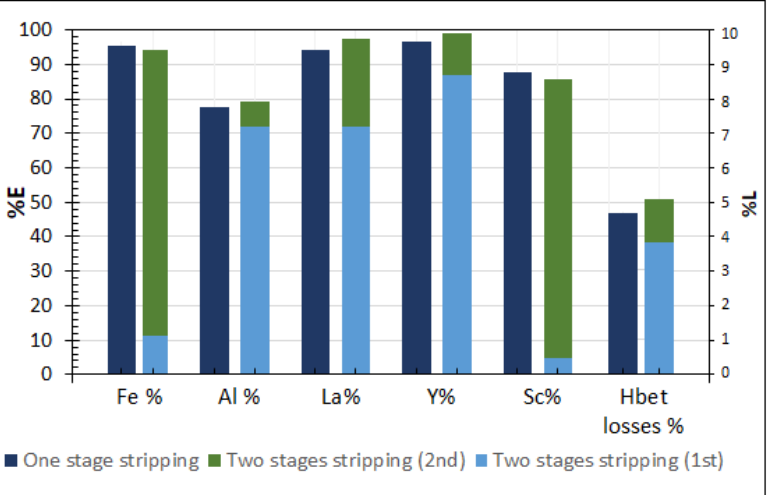
Figure 7. Comparison of the metal extraction and ionic liquid losses through the two different stripping approaches. stripping